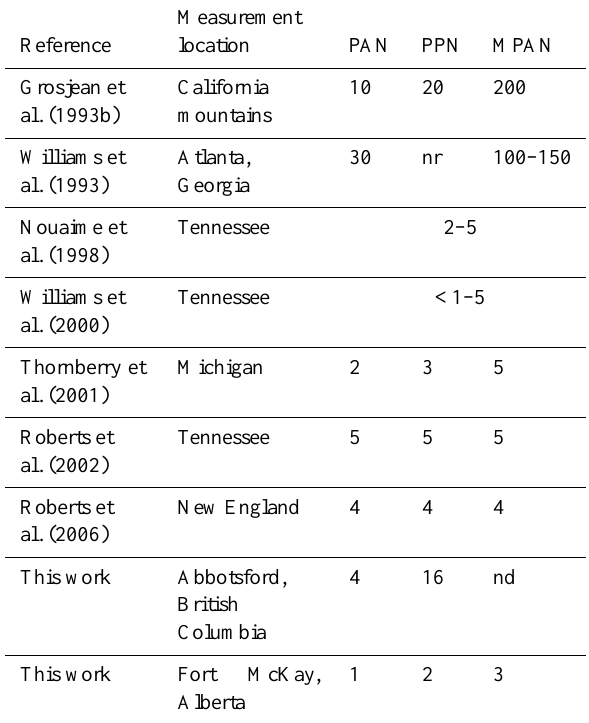
Table 13. Selected LODs of ambient air measurements of PAN, PPN and MPAN by GC-ECD reported in the literature. nr = not re- ported, nd = not